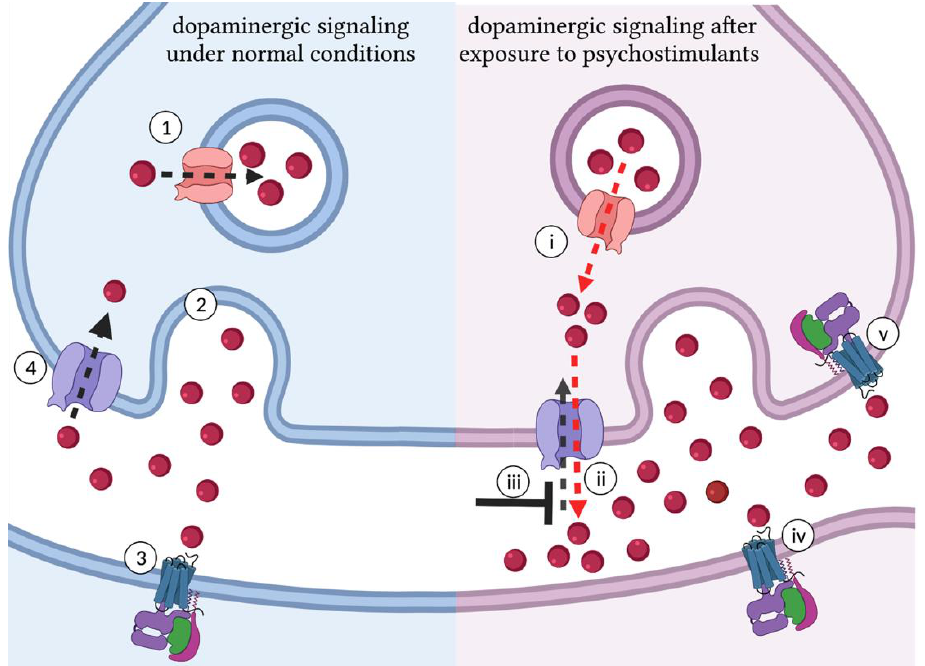
Figure 1. Dopaminergic signaling in the absence (blue background) and presence (pink background) of psychostimulant drugs. On the left, the steps of dopaminergic signaling represented include: (1) uptake of cytoplasmic dopamine by VMAT2 (black dashed line), (2) vesicular release of dopamine, (3) binding of neurotransmitter to post-synaptic dopamine receptor, and (4) reuptake of dopamine by the dopamine transporter (black dashed line). The increase in dopaminergic signaling caused by psychostimulant drugs is depicted on the right and include: (i) depletion of vesicular dopamine following interaction of VMAT with amphetamine-like psychostimulant drugs (red dashed line), (ii) amphetamine-induced reverse transport of dopamine (red dashed line), (iii) blockade of dopamine uptake (inhibition of black dashed line) by cocaine or methylphenidate, (iv) increased binding and activation of post synaptic dopamine receptor, and (v) increased binding and activation of pre- synaptic D2-like autoreceptor. Created with BioRender.com.